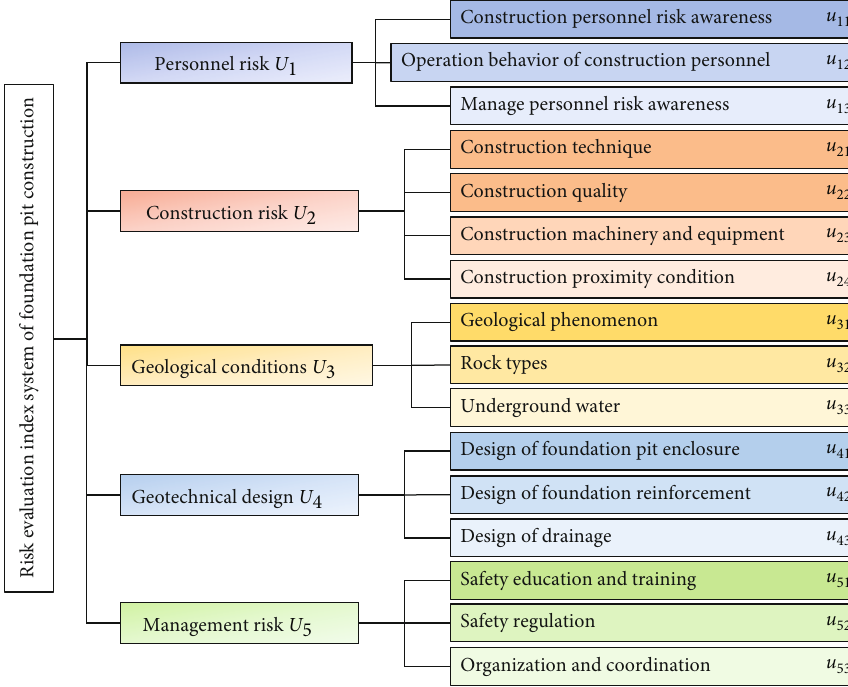
Figure 4: Risk evaluation index system of foundation pit construction.